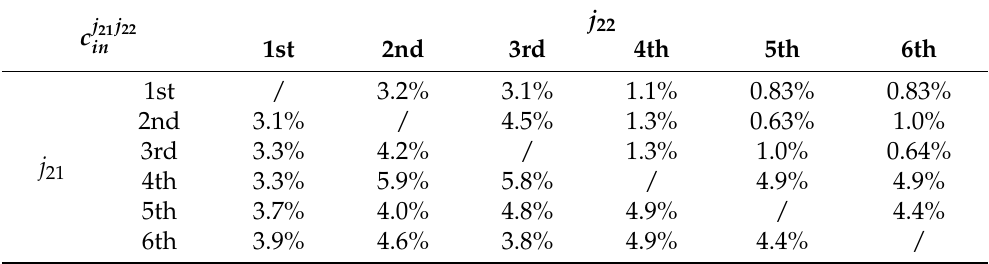
Table 5. Input coupling ratio of the 6-RRRR NPS using the FEM.